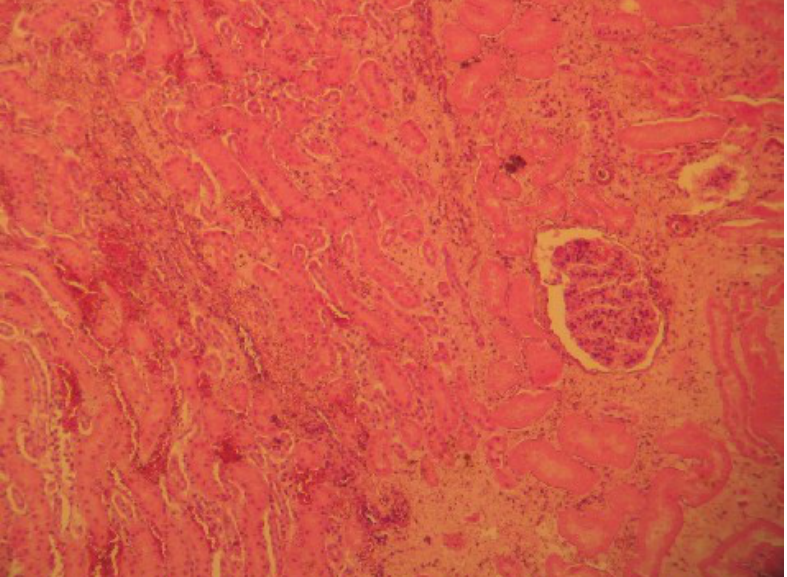
Figure 2. Histological features: hyperemia, degeneration and renal tubules necrosis in the renal